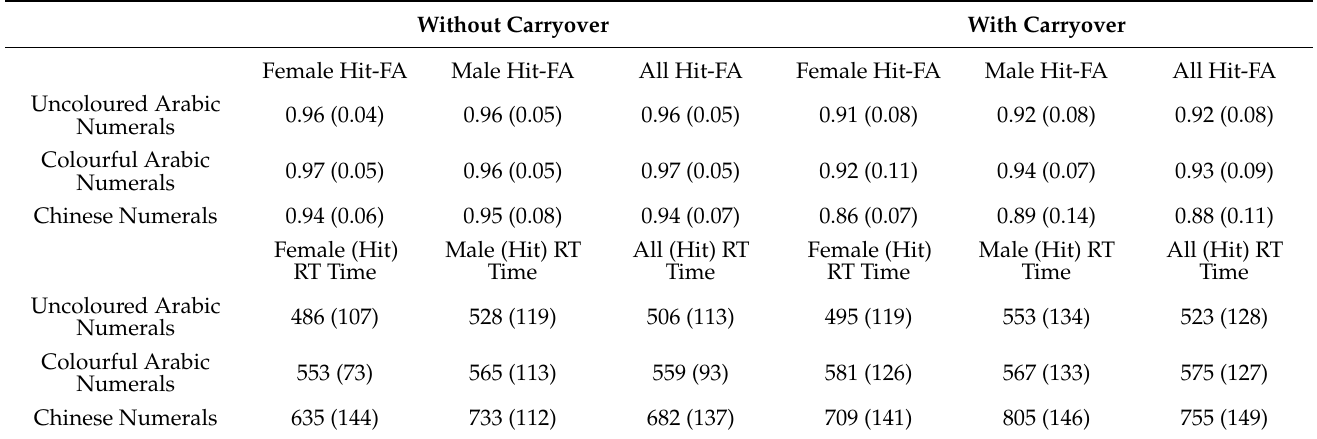
Table 1. The mean percentages of corrected behavioural performance in percentages (hit–false alarm) on simple addition tasks and the correct response time in milliseconds on simple addition tasks. Standard deviations are shown in